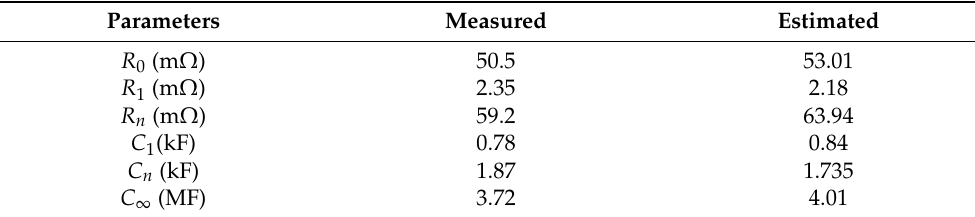
Table 13. Results of Case 6.